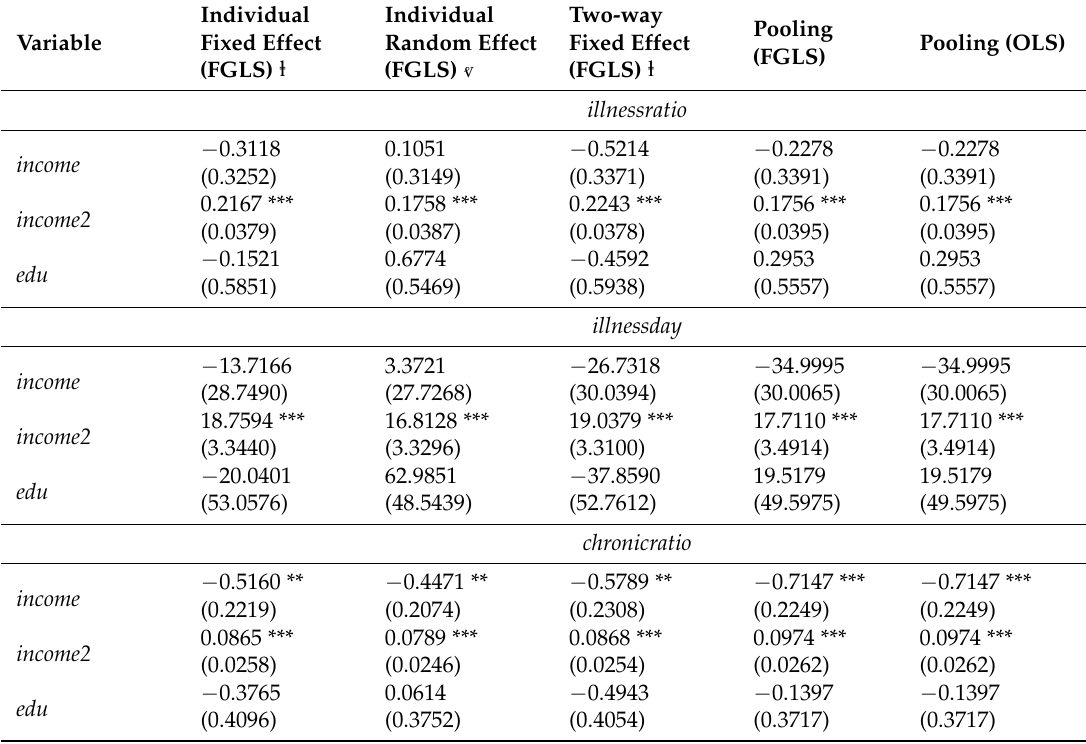
Table 4. Results of the regression analysis on NHSS dataset.